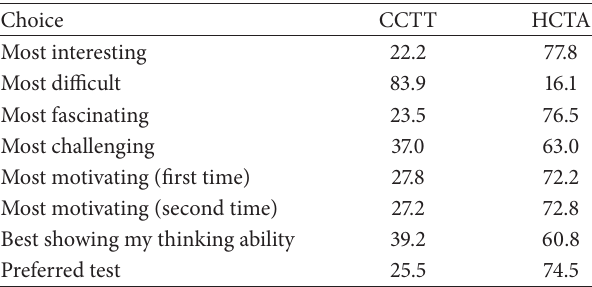
Table 12: Students’ preference of one of the instruments (%) ( 𝑁 = 132